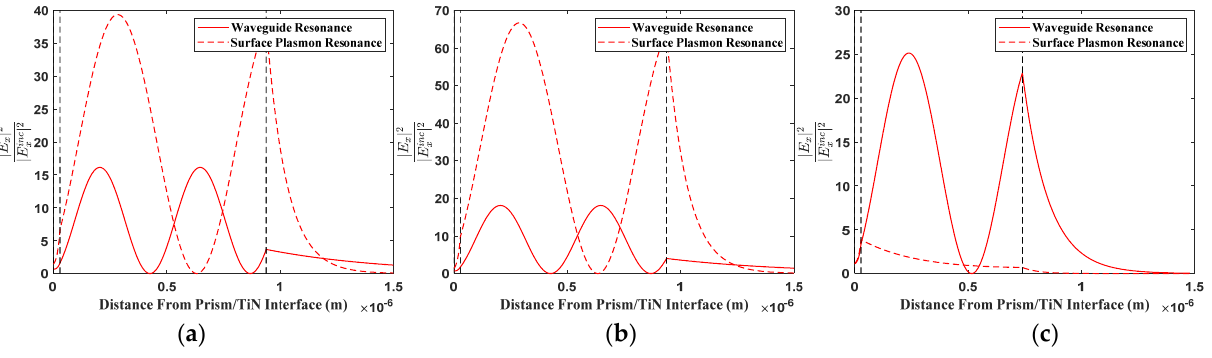
Figure 4. The calculated penetration depth (d p ) for TM–polarized light for the GA–optimized sap- phire (Al 2 O 3 ) prism/TiN/AlN/air, magnesium oxide (MgO) prism/TiN/AlN/air, and silicon (Si) prism/TiN/AlN/air sensors was 181 nm, 182 nm, and 136 nm, respectively. 3.4. Field Distribution for TE Polarized Light The TE–polarized incident light is also beneficial since the TE modes may provide information about the anisotropy in ultrathin films. The detailed descriptions and exam- ples for lipid orientation determination can be found in [57]. Figure 5 shows the magnetic field distribution for TE modes in the AlN layer for the optimized CPWR sensors. The TE modes in the AlN waveguides were the same for these three sensors. For the sapphire prism/TiN/AlN/air and magnesium oxide prism/TiN/AlN/air sensors, the magnetic fields